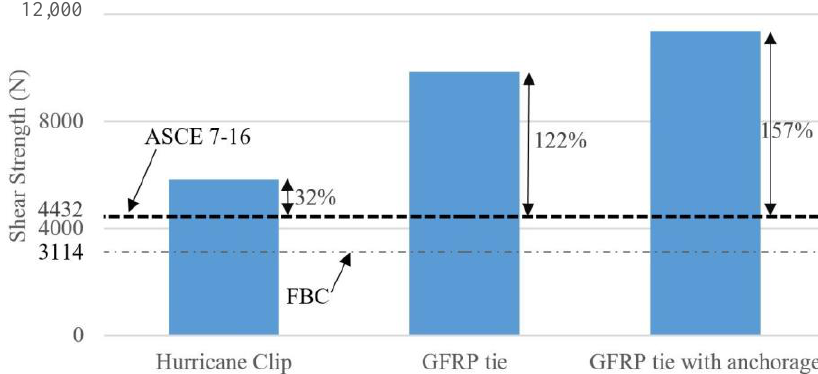
Figure 17. Improvement in uplift capacity.